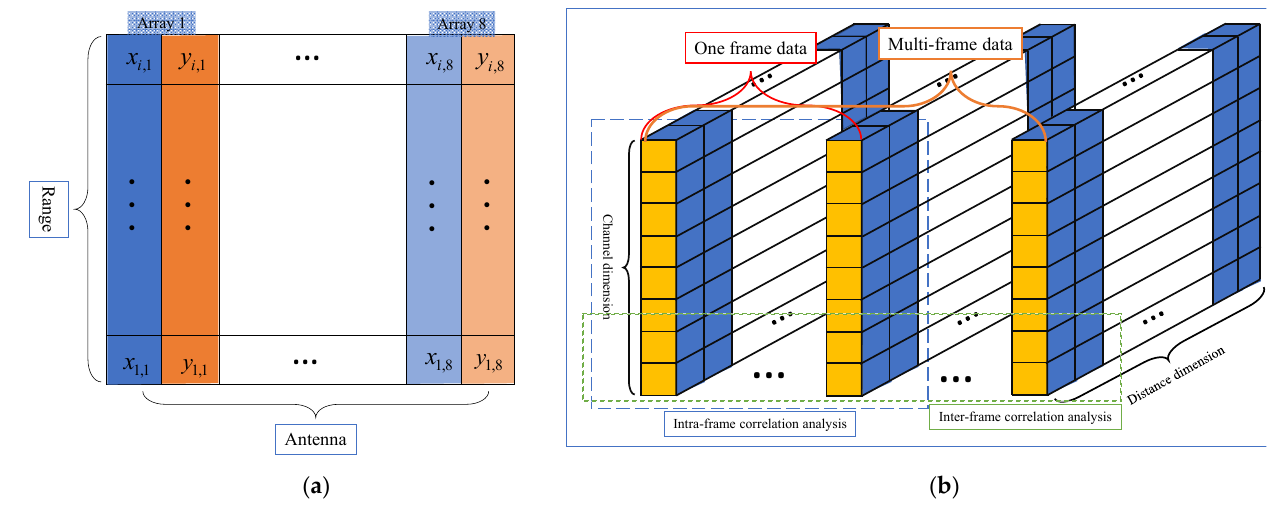
Figure 5. Schematic diagram of multi-dimensional data correlation analysis of UCA radar. ( a ) Schematic diagram of multi-channel single pulse data; ( b ) Schematic diagram of multi-channel and multi-pulse data.